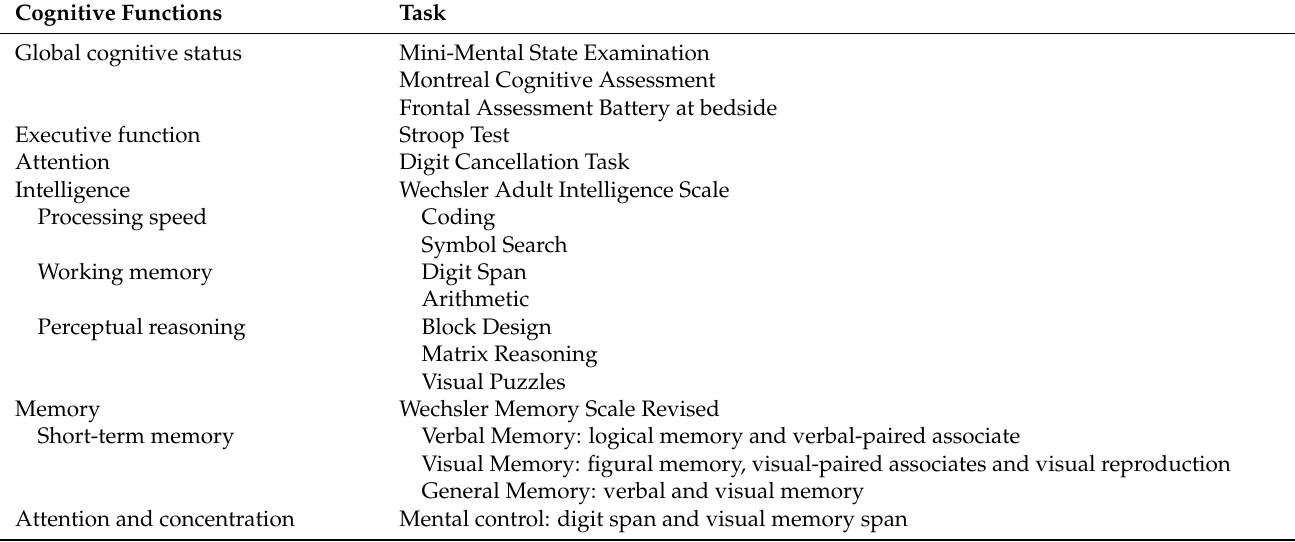
Table 1. Cognitive function